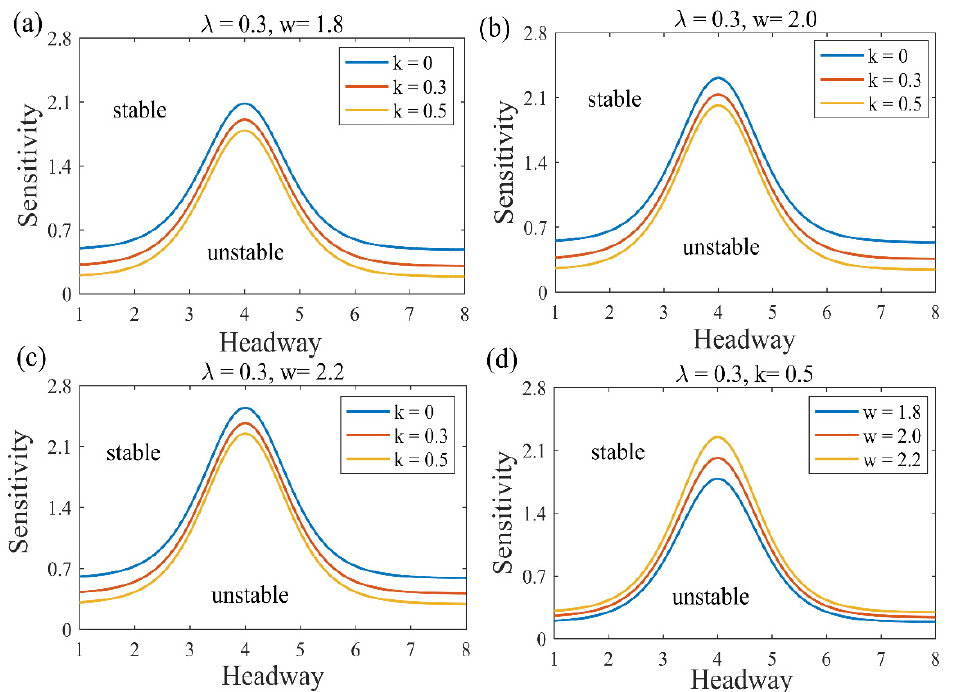
λ w and . λ w and .